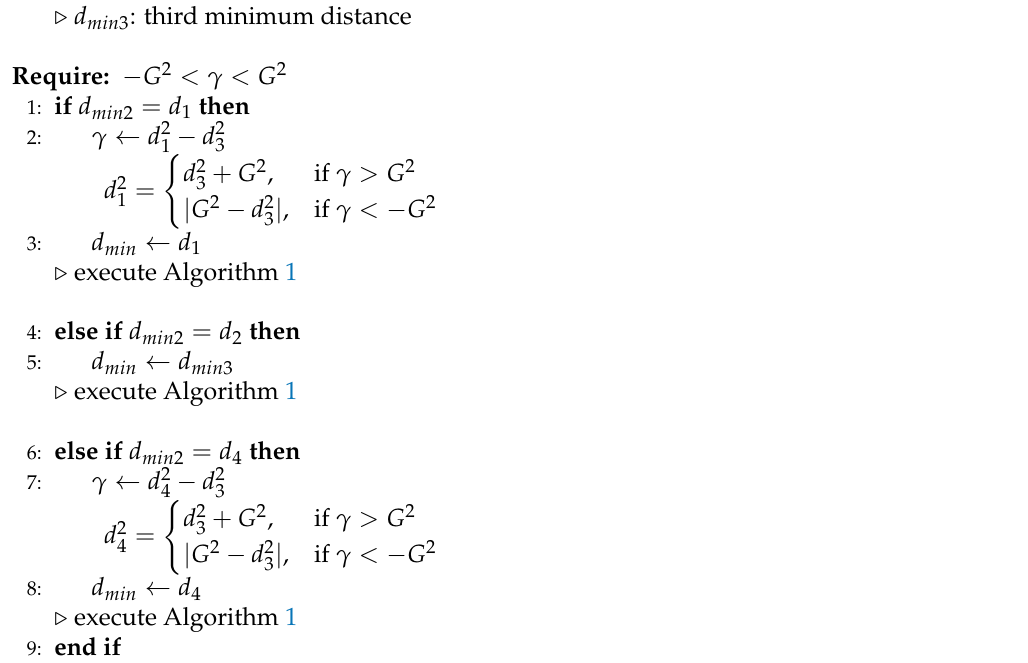
Algorithm 2 Case 2: d min = d